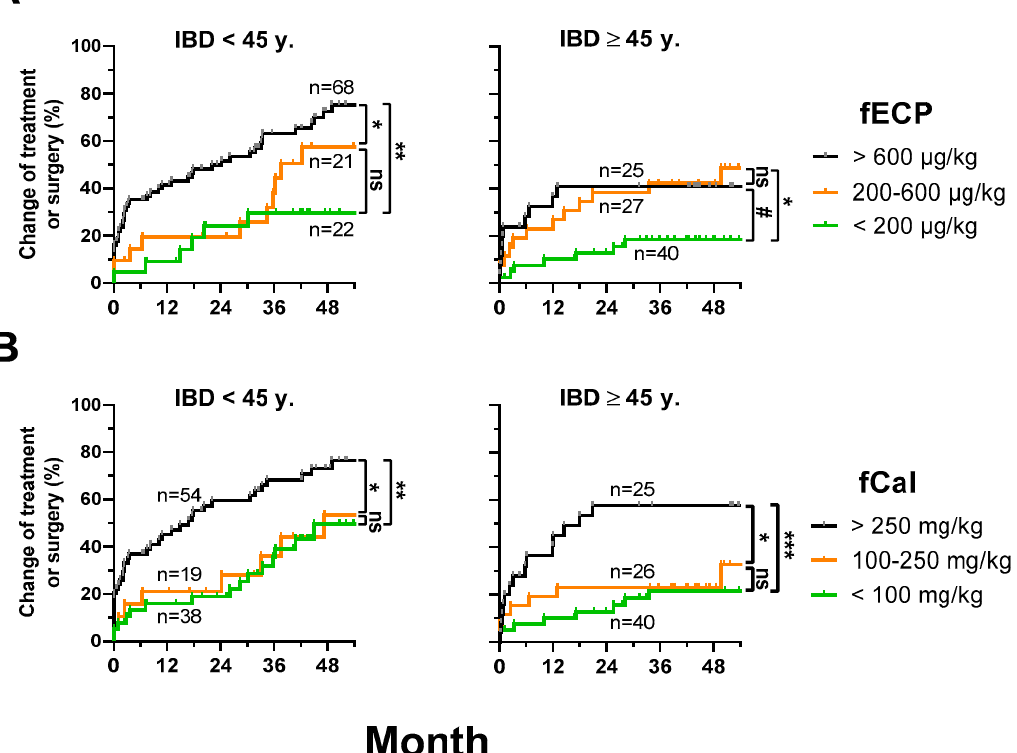
Figure 2. fECP as a predictive marker in IBD. Inverse Kaplan–Meier curves for time to treatment modification (only immunosuppressants and biologics) or surgery during follow up depending on ( A ) different levels of fECP and ( B ) different levels of fCal at baseline. P-values were calculated with log-rank (Mantel–Cox) test. ns (non-significant), p > 0.07; #, p ≤ 0.07; *, p < 0.05; **, p < 0.01; ***, p < 0.001.